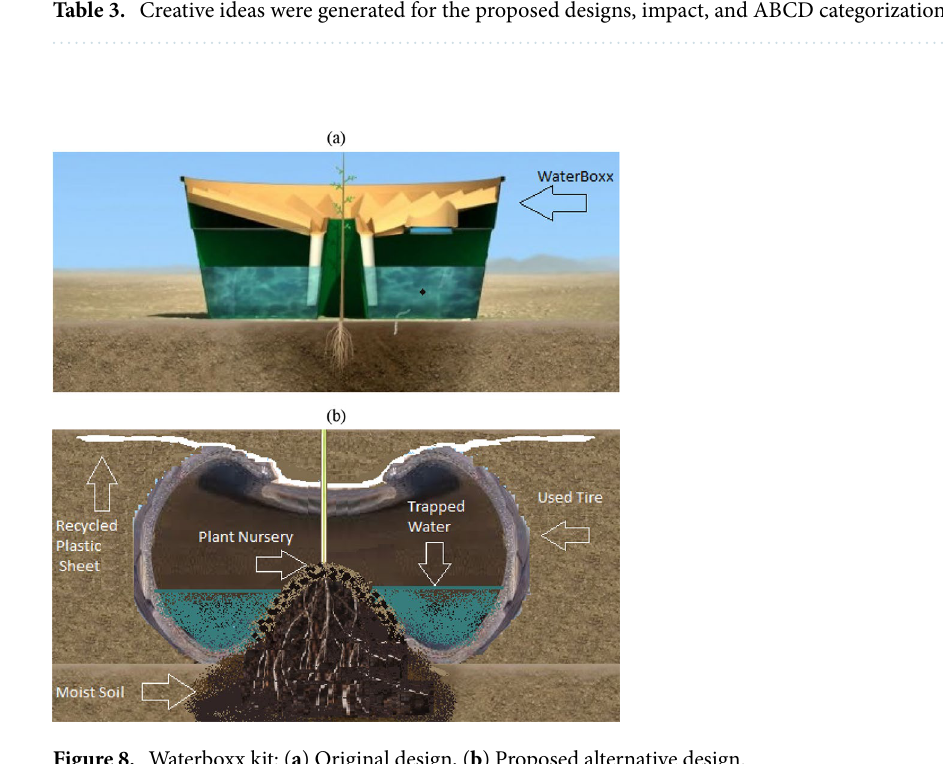
Figure 8. Waterboxx kit: ( a ) Original design, ( b ) Proposed alternative